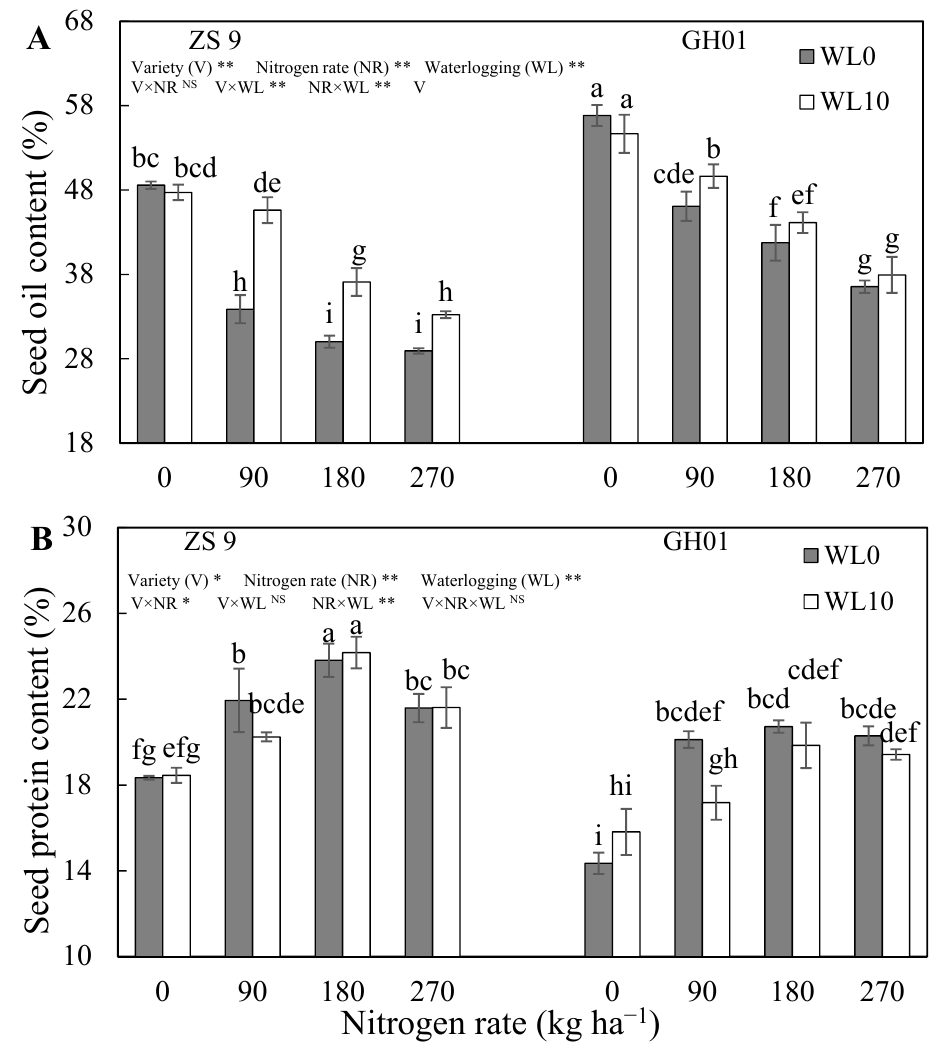
Figure 1. E ff ect of nitrogen rates on seed oil and protein content of waterlogged rapeseed (( A ), seed oil content; ( B ), Seed protein content). WL0, plants without waterlogging; WL10, plants waterlogged for 10 days at the seedling stage. Values followed by di ff erent letters are significantly di ff erent at the 0.05 probability level according to LSD test. * Significant at the 0.05 probability level. ** Significant at the 0.01 probability level. NS, not significant according to ANOVA.